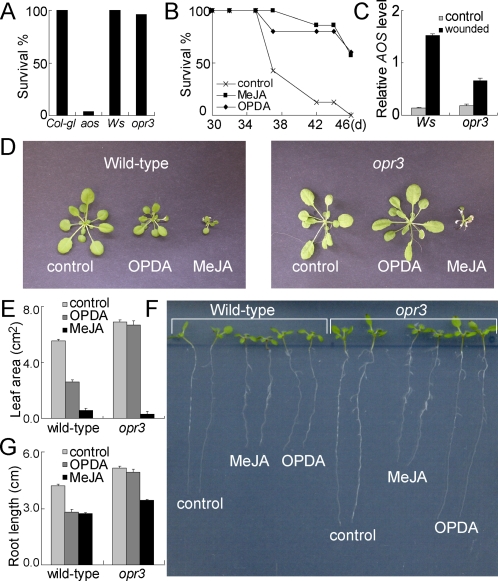
JA and OPDA in defence against Bradysia impatiens, and growth inhibition.(A) Survival of Col-gl, aos, Ws and opr3 plants grown in soil infested with larvae of Bradysia impatiens. Adult flies were introduced at day 14 and survival was counted on day 46. (B) Survival of aos plants grown in soil infested with larvae of Bradysia impatiens as (A) and sprayed with MeJA (100 µM), or OPDA (100 µM), or water as a control at day 30, 32 and 35. (C) Quantitative RT-PCR was used to measure the expression of AOS in Ws and opr3 plants untreated as control or wounded twice on two leaves. The AOS level was relative to ACTIN2. (D) OPDA (100 µM) or MeJA (100 µM) was applied to leaves of wild type and opr3 plants at days 21, 23 and 25. Images are of plants at 31 days. (E) Leaf area of plants from (D). (F) Five-day-old wild type Ws and opr3 plants were transferred to MS as control and MS containing 10 µM MeJA or 10 µM OPDA. Images were taken 7 days after transfer. (G) Length of roots of seedlings from (F) (n≥21).